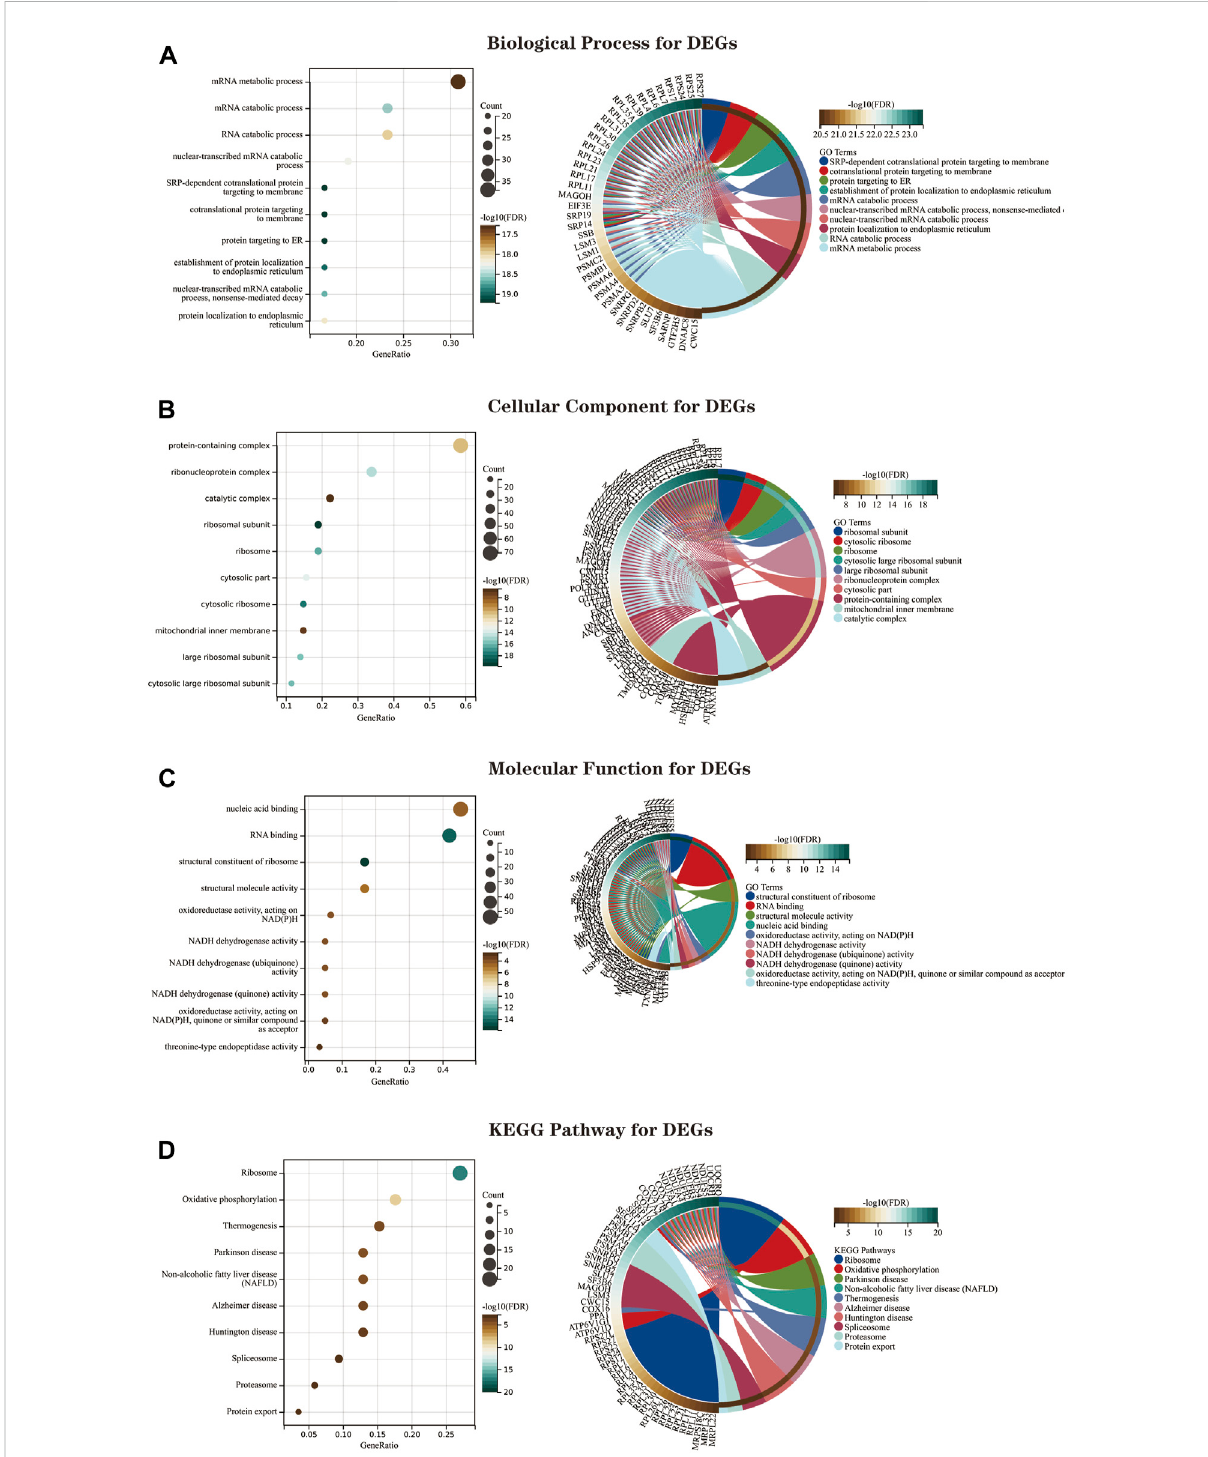
FIGURE 6 The GO and KEGG enrichment analysis results of 134 DEGs are shown as bubble and circle plots. (A) Shows the top 10 signi fi cantly enriched BP (biological process). (B) Shows the top 10 enriched CC (cellular component) considerably. (C) The top 10 enriched MF considerably (molecular function) are shown. (D) The top 10 signi fi cantly enriched KEGG pathways. In the bubble plot of GO and KEGG enrichment analysis, the x -axis represents the GeneRatio, the y -axis represents the -log10 (FDR) value, the bubble size represents the number of genes, and the color shades represent the size of the FDR value. The linkage between the left and right sides indicates the correlation between DEGs and terms. Abbreviations: DEGs (Differential Expressed Genes), GO (Gene Ontology), KEGG (Kyoto Encyclopedia of Genes and